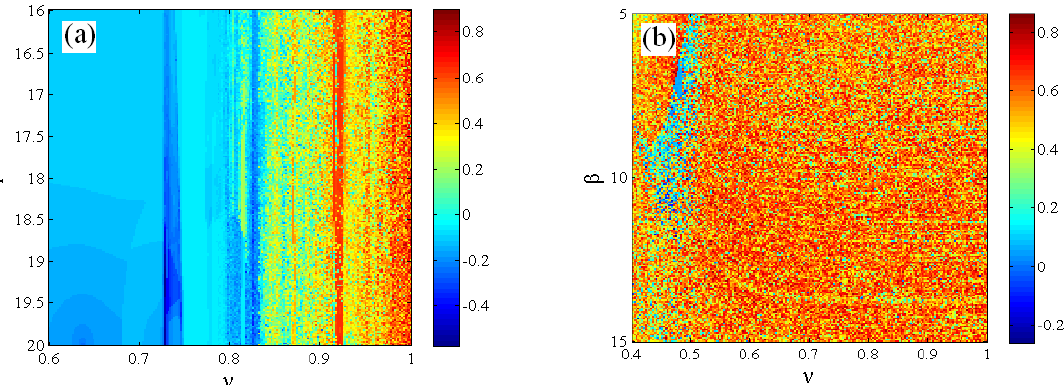
Figure 5. Phase portrait. ( a ) Phase portrait with ν = 0.2; ( b ) phase portrait with ν = 0.5.